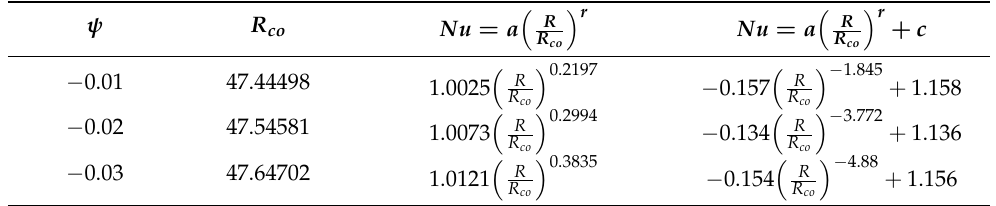
Table 1. Power law equations for different ψ